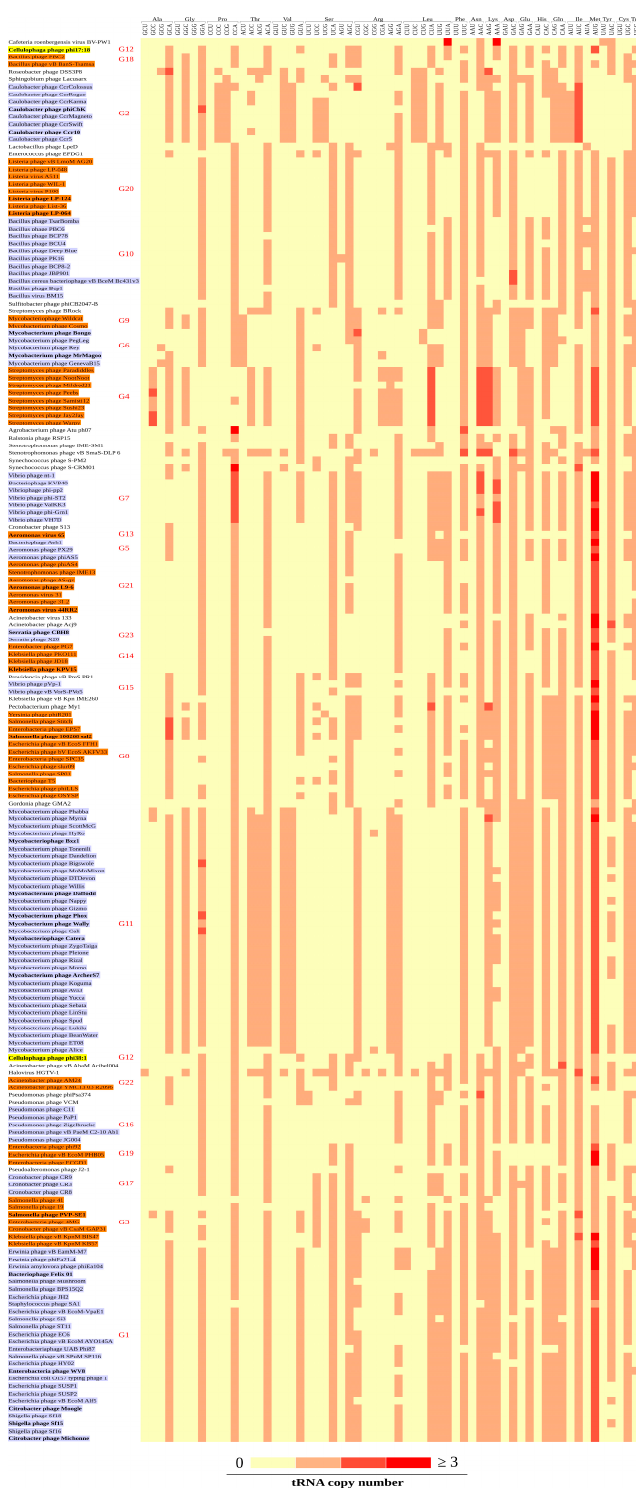
Figure 2. Codon patterns of the tRNA gene clusters. The heatmap shows the tRNA gene copy number (codons and isotypes) of each tRNA gene cluster. The background color of the labels is associated with each tRNA gene cluster group (indicated by the red labels or shown in Figure S1). The yellow background labels represent the Cellulophaga phages with the same tRNA gene cluster group. Genomes having identical codon pattern were collapsed, represented by the bold label. A larger version of this figure is provided in Figure